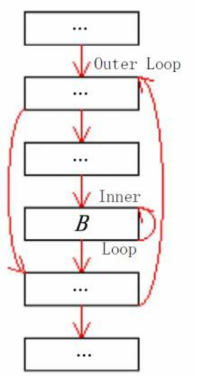
Figure 5. The control flow graph (CFG) of a program with non-orthogonal nested